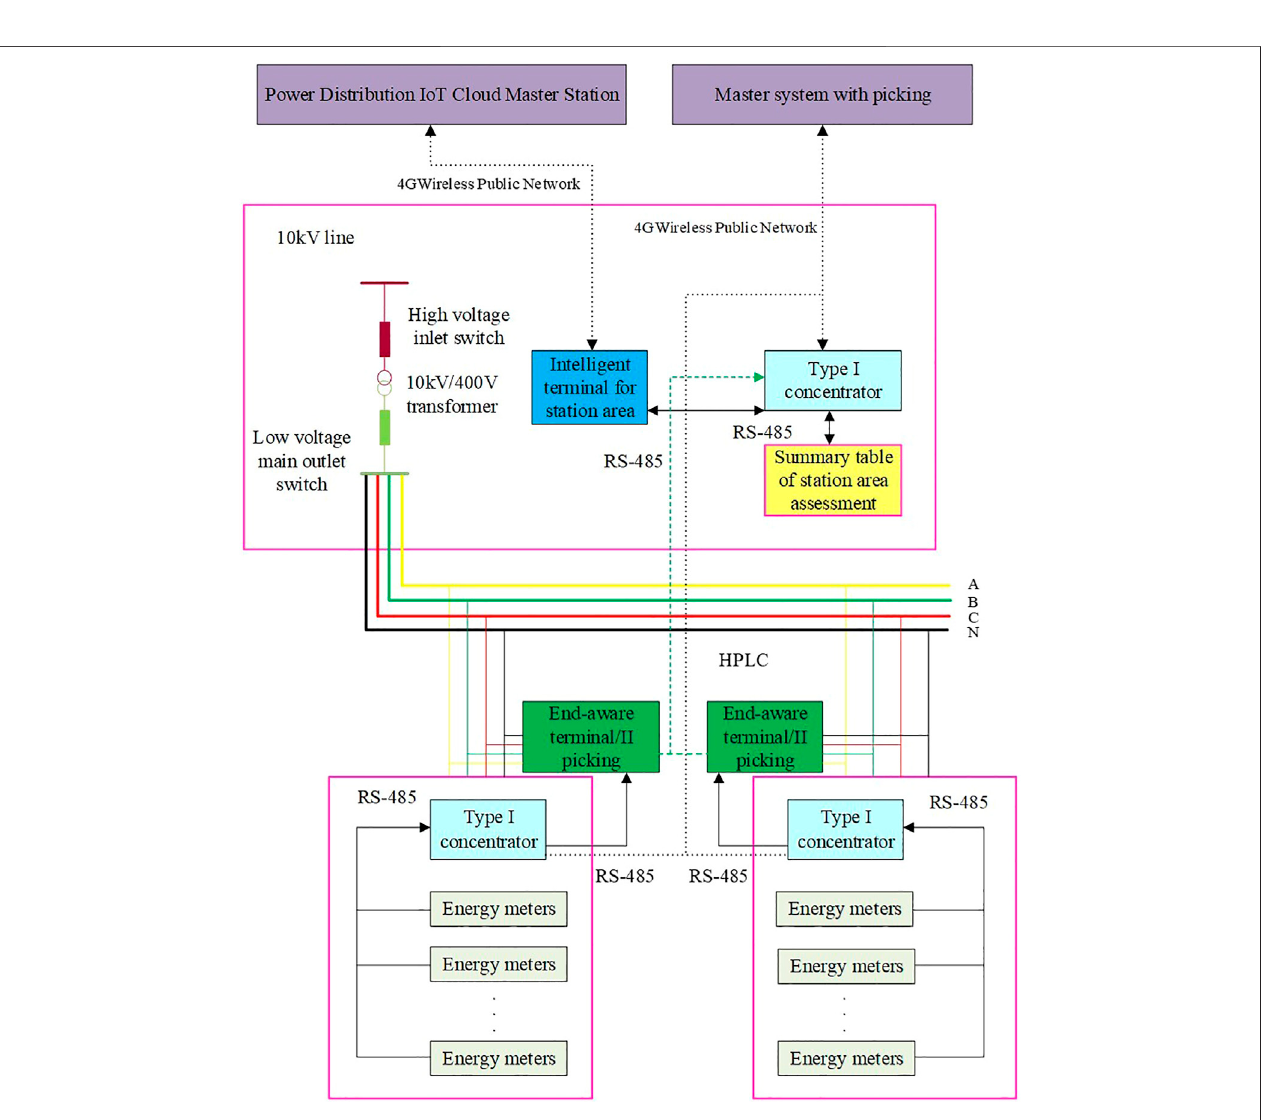
FIGURE 3 | Scheme 1 interaction